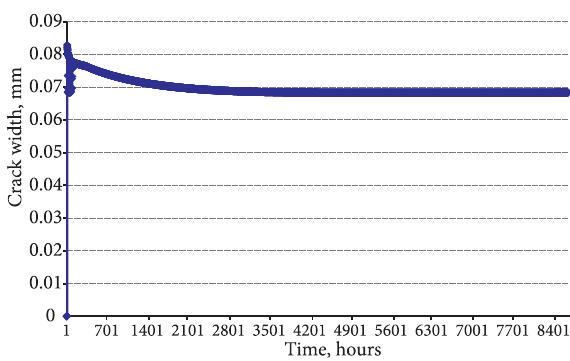
Fig. 6. Development of the longitudinal crack width during 1 year; Friction 5 – pavement width 9